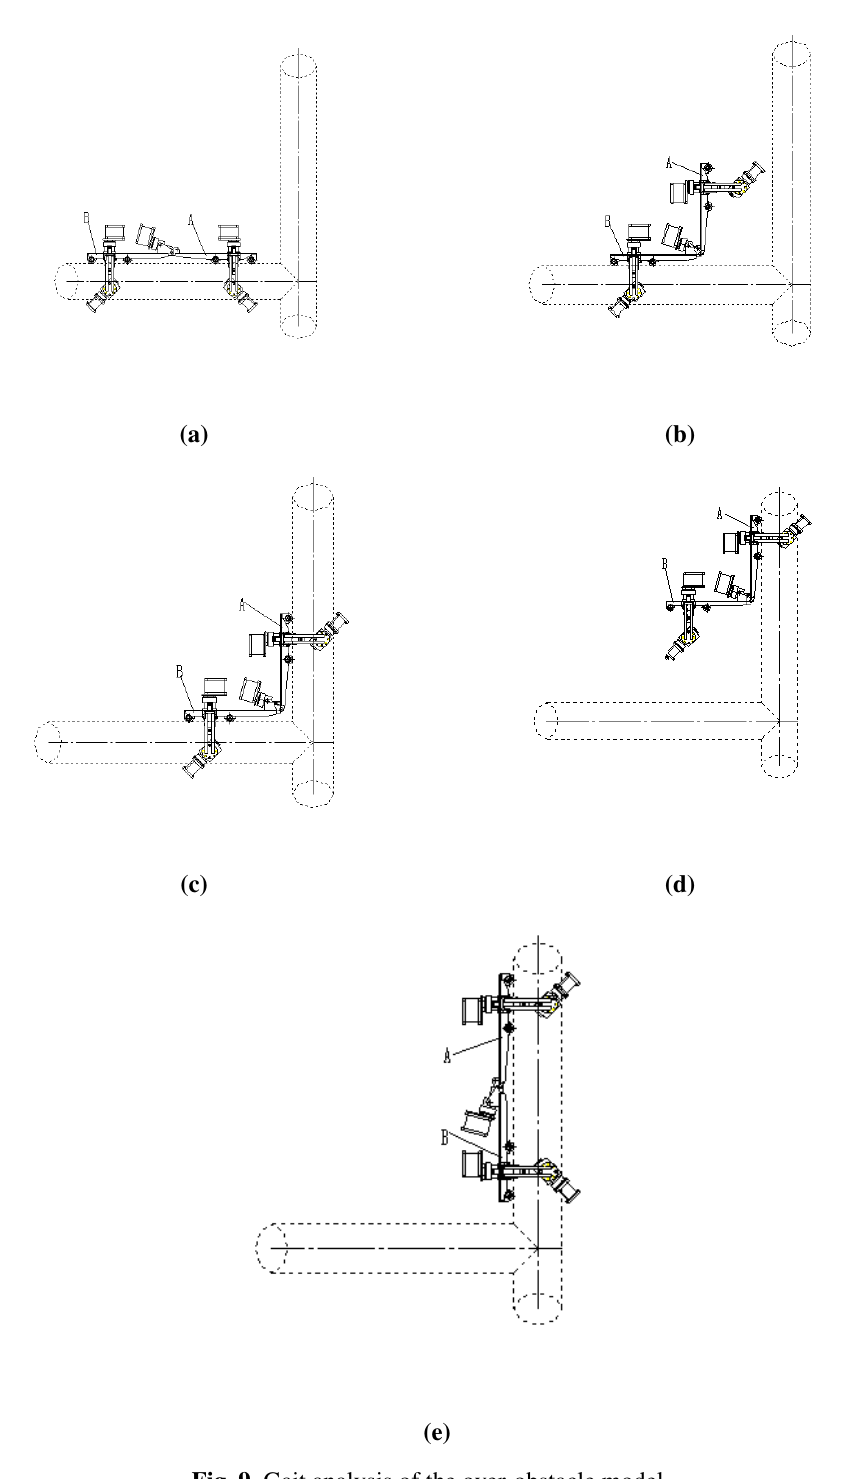
Fig. 9 Gait analysis of the over-obstacle